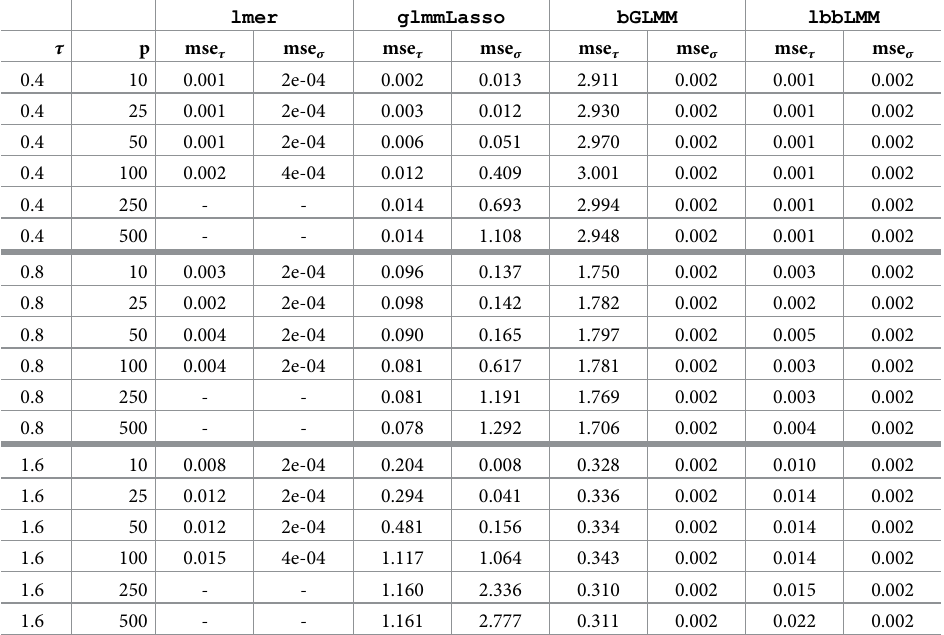
and mse of 100 independent simulation runs for each random intercepts τ σ